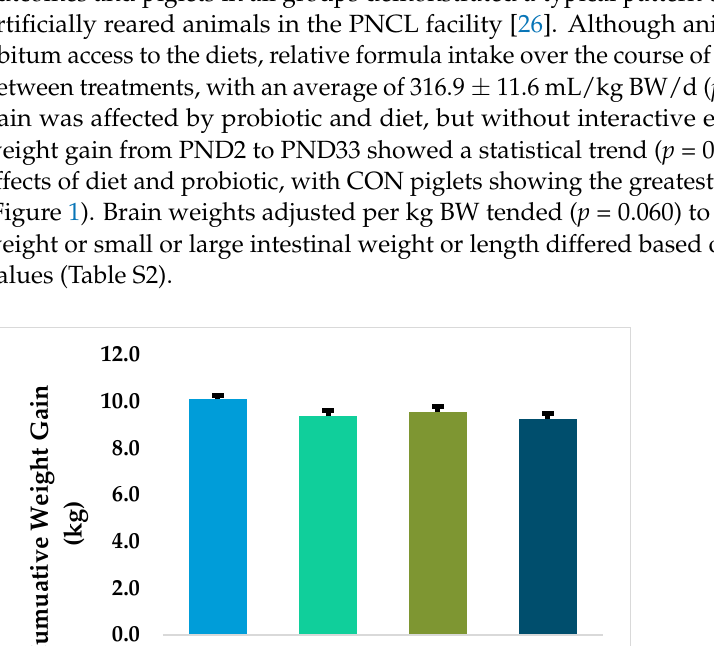
Table 2. Ileum Histomorphology.